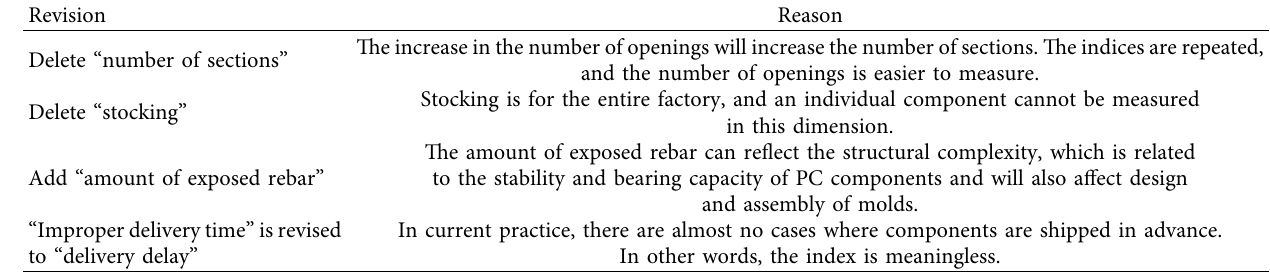
Table 4: Additional revisions to some indices.